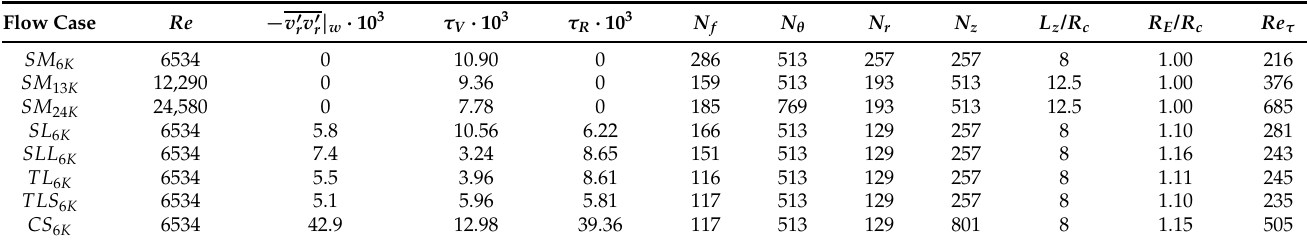
Table 1. List of parameters for the flow cases herein considered. The subscripts (6 K , 12 K , 24 K ) indicate the values of the bulk Reynolds number ( Re ), given in the second column. N f is the number of fields used to evaluate the statistics, spaced one outer time unit apart. N θ , N r , N z are the number of grid points in the azimuthal, wall-normal, and streamwise directions. L z is the streamwise domain length, and R E is the radius of the equivalent circular duct. Re τ is the friction Reynolds number.